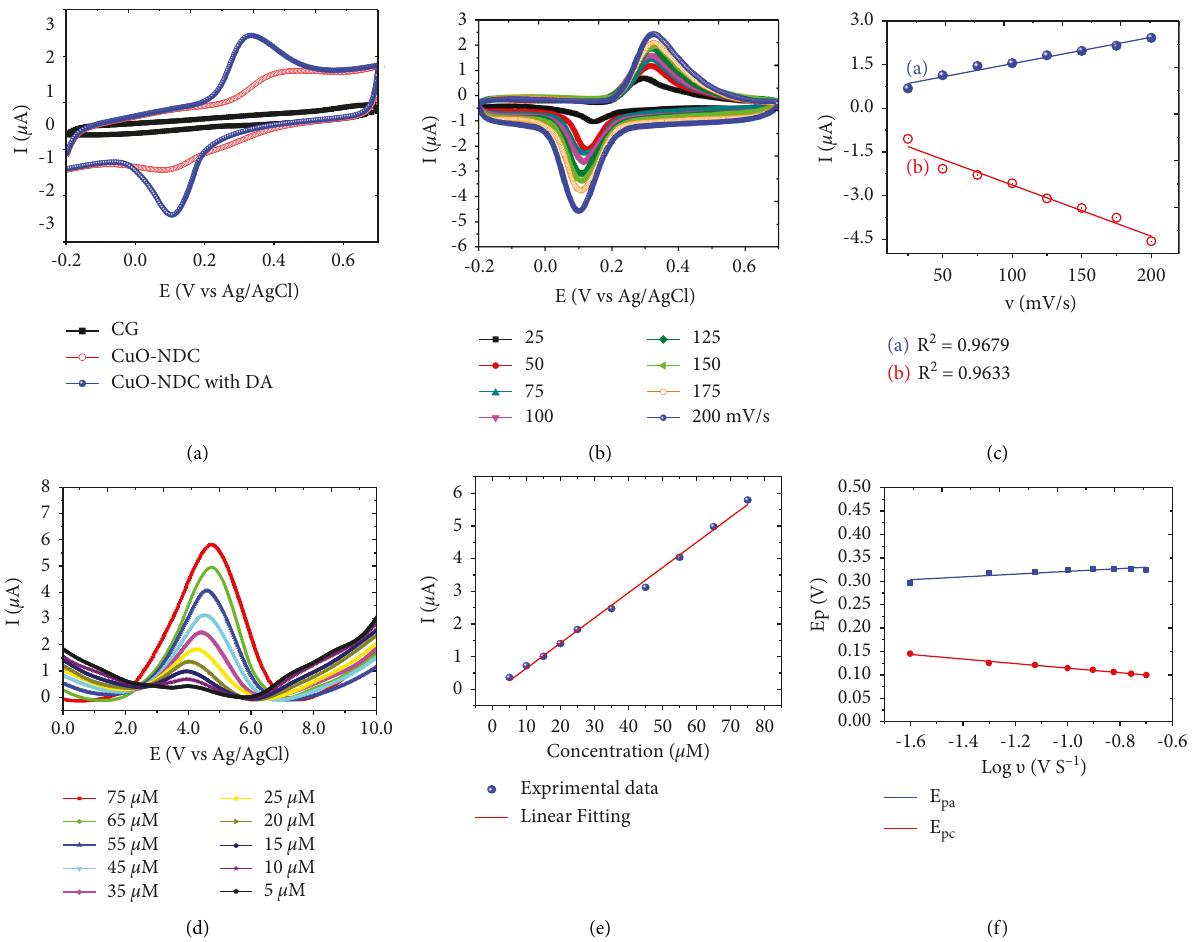
Figure 4: (a) Cyclic voltammograms of GCE, NDC, and CuO-NDC with DA at 100mV/s scan rate, (b) cyclic voltammograms of CuO-NDC at different scan rates (25, 50, 75, 100, 125, 150, 175, and 200mV/s), (c) relationship between redox peak current and scan rate ( v ); (d) differential pulse voltammograms of different concentrations of dopamine on CuO@NC electrode in electrolyte solution, (e) plot of current versus concentration of DA, and (f) relationship between the peak potential ( Ep ) and the natural logarithm of scan